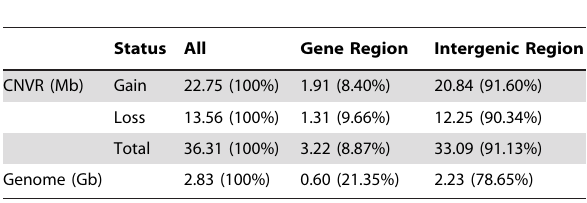
Table 1. Gene and intergenic constitution in CNVRs and whole genome.